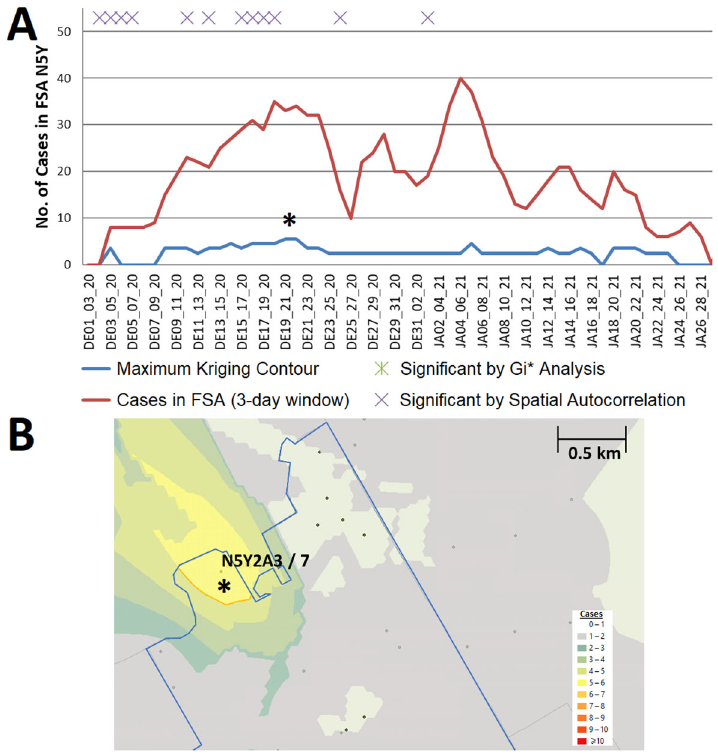
Figure6.ExampleofalocalizedhotspotinLondonOntario. (A)GeostatisticalanalysisoftheFSAN5Y(London,ON) identifies a localized hotspot from Dec. 19 th to the 22 nd . Estimates from kriging were lower than actual case counts. (B) The kriging contour of a localized hotspot (yellow) interpolated with ≥ 5 cases encompasses 4% of the FSA area. Dots indicate PCs at least 1 case, however only those with ≥ 6 cases are labelled (with PC identifier/case